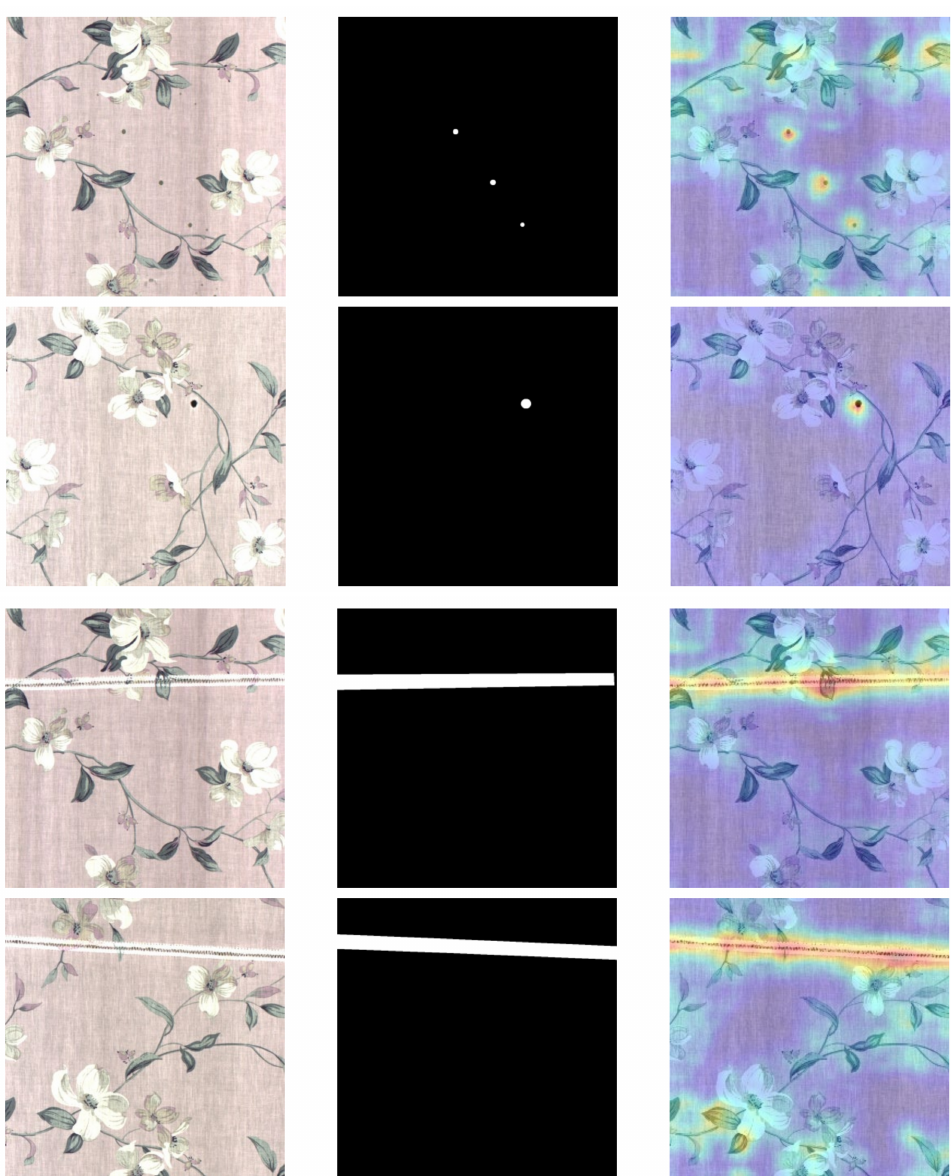
Figure 7. Inspection results of our proposed method on the color fabric dataset. The first two rows represent a tiny dot defect, and the latter two rows represent large-span scratch defects. The first column is the original image, the second column is the ground truth, and the third column is an anomaly